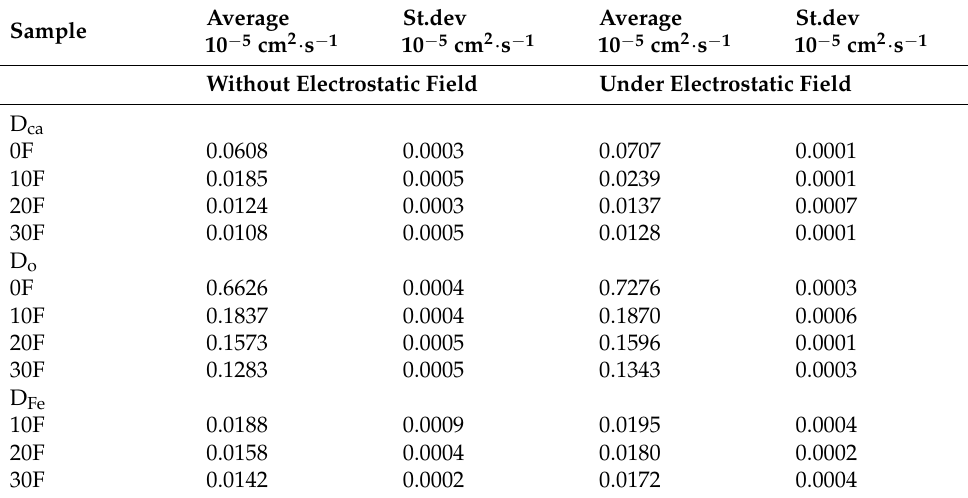
Table 3. The 10 5 self-diffusion coefficients of Ca 2+ (D ca ) and water molecules (D o ) with no Fe 2+ ions added ( 0F ) and ten Fe 2+ added ( 10F ), twenty Fe 2+ added ( 20F ), and thirty Fe 2+ added ( 30F ) with and without